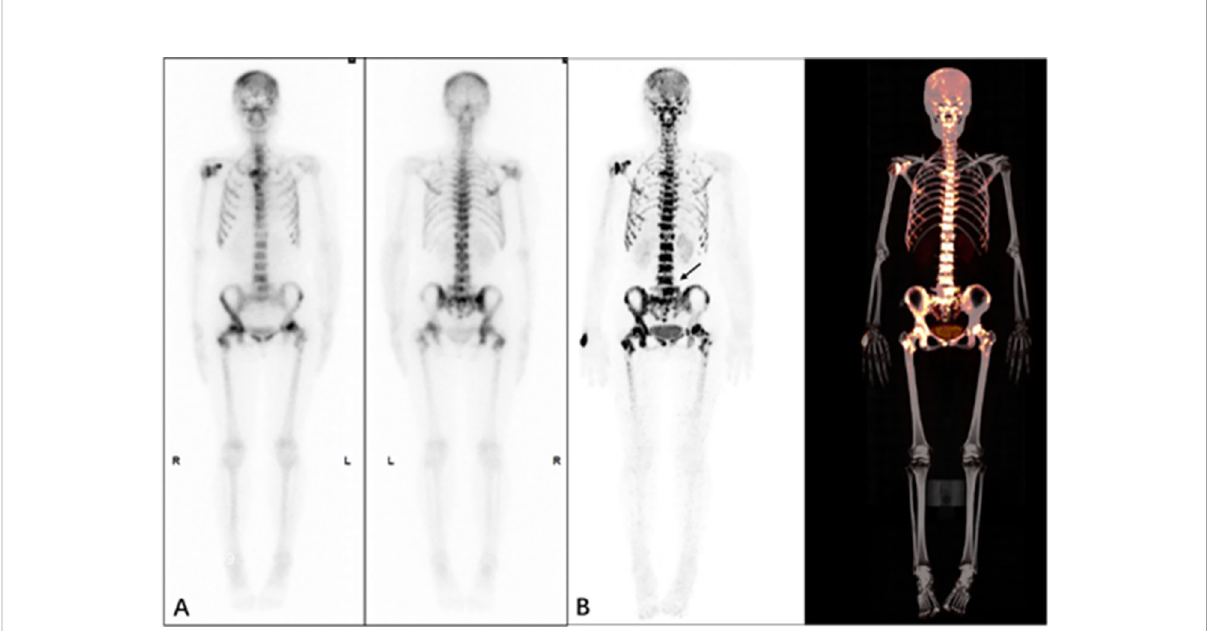
FIGURE 9 A 66-year-old female patient who underwent surgery for left breast cancer one year ago and now has generalized skeletal pain. The patient underwent 99m Tc-MDP (A) and 68 Ga-DOTA-IBA (B) imaging. From the MIP image, multiple foci of abnormal developer concentrations can be seen throughout the mesial bones and pelvic bones with a SUVmax of approximately 6.8 for the lesion, T/NT 5.2